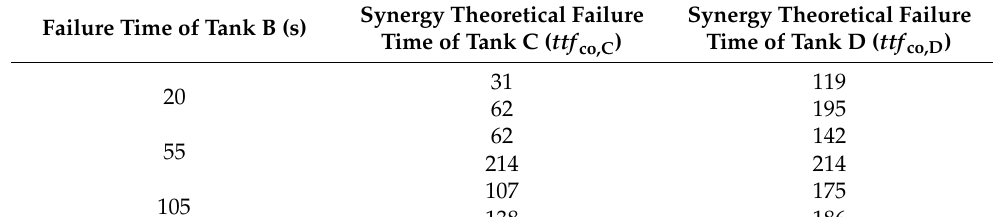
Table 3. Theoretical failure time of tank B, C, D under synergy effect.